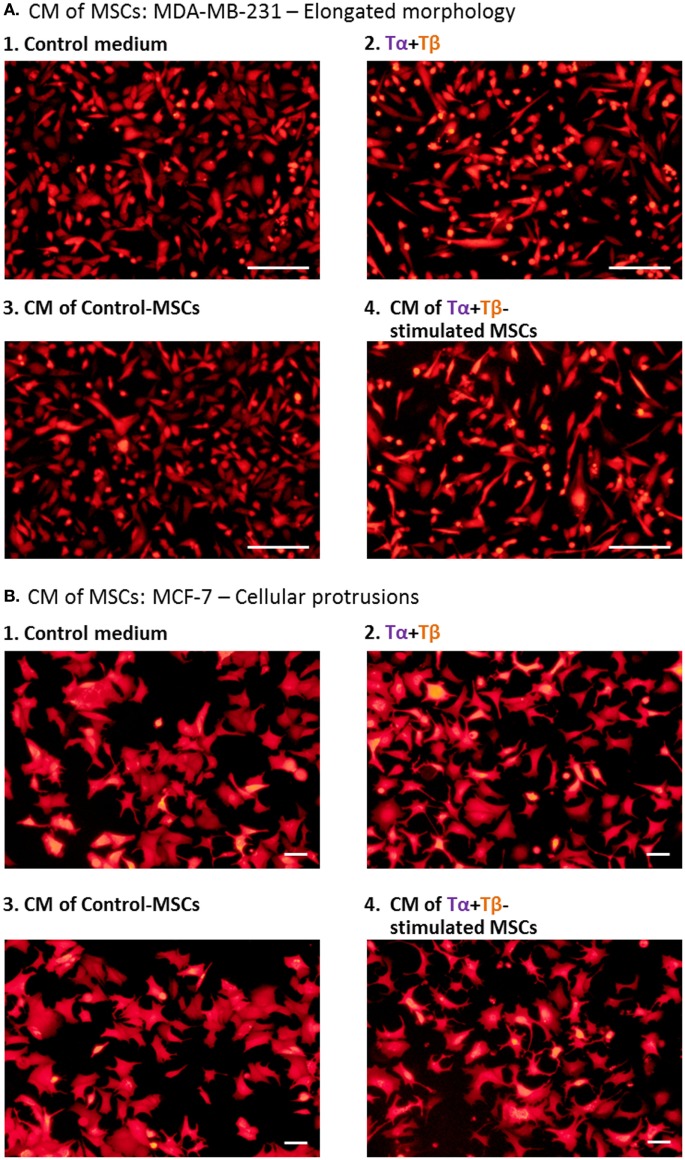
Factors released by TNFα + TGFβ1-stimulated MSCs induce cellular elongation and formation of cellular protrusions in human breast cancer cells. Human BM-derived MSCs were stimulated with vehicle (“Control-MSCs”) or TNFα (50 ng/ml) + TGFβ1 (10 ng/ml), in 0.5% FBS-containing medium; Tα + Tβ = TNFα + TGFβ1. In parallel, samples of “Control medium” (not exposed to MSCs), with or without the stimulating cytokines, were kept in identical conditions. Twenty-four hours later, all different media were filtered (0.45 µm pores) and applied to mCherry-expressing MDA-MB-231 cells for 48–72 h, in different experiments (A) or to mCherry-expressing MCF-7 cells for 48 h (B). Cancer cells were then washed and photographed. CM = conditioned media. Scale bar: 200 µm in MDA-MB-231 cells and 50 µm in MCF-7 cells. The pictures are representatives of n ≥ 3 independent experiments, performed with MSCs of two to three different donors, which have shown similar results. For MDA-MB-231 cells, enlarged pictures of cells, obtained in MSCs from another experiment, are demonstrated in Figure S8 in Supplementary Material.